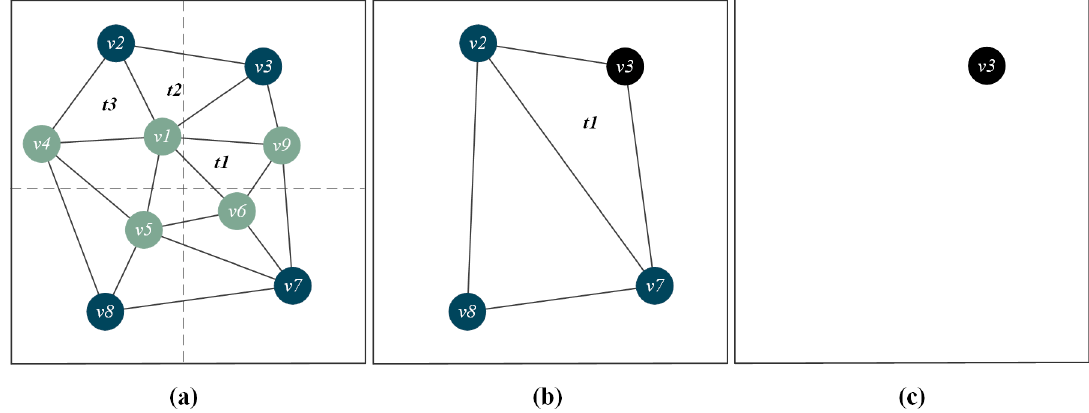
Figure 2. Multi-level vertex clustering: ( a ) Original mesh; ( b ) the result of vertex clustering on ( a ); ( c ) the result of vertex clustering on ( b ).